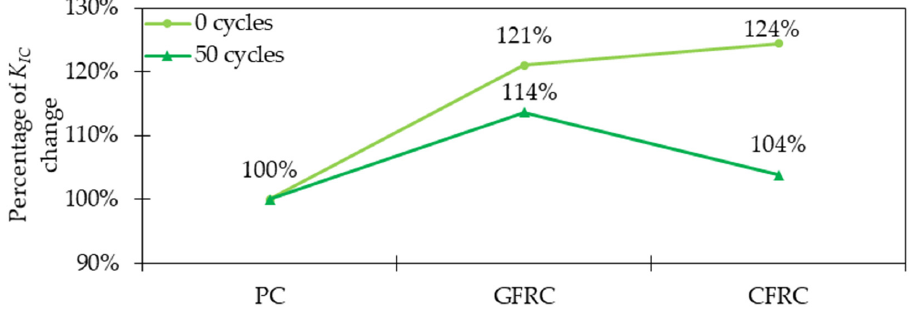
Figure 25. Change of K IC for PC, GFRC, and CFRC subjected to freeze-thaw cycles [113].